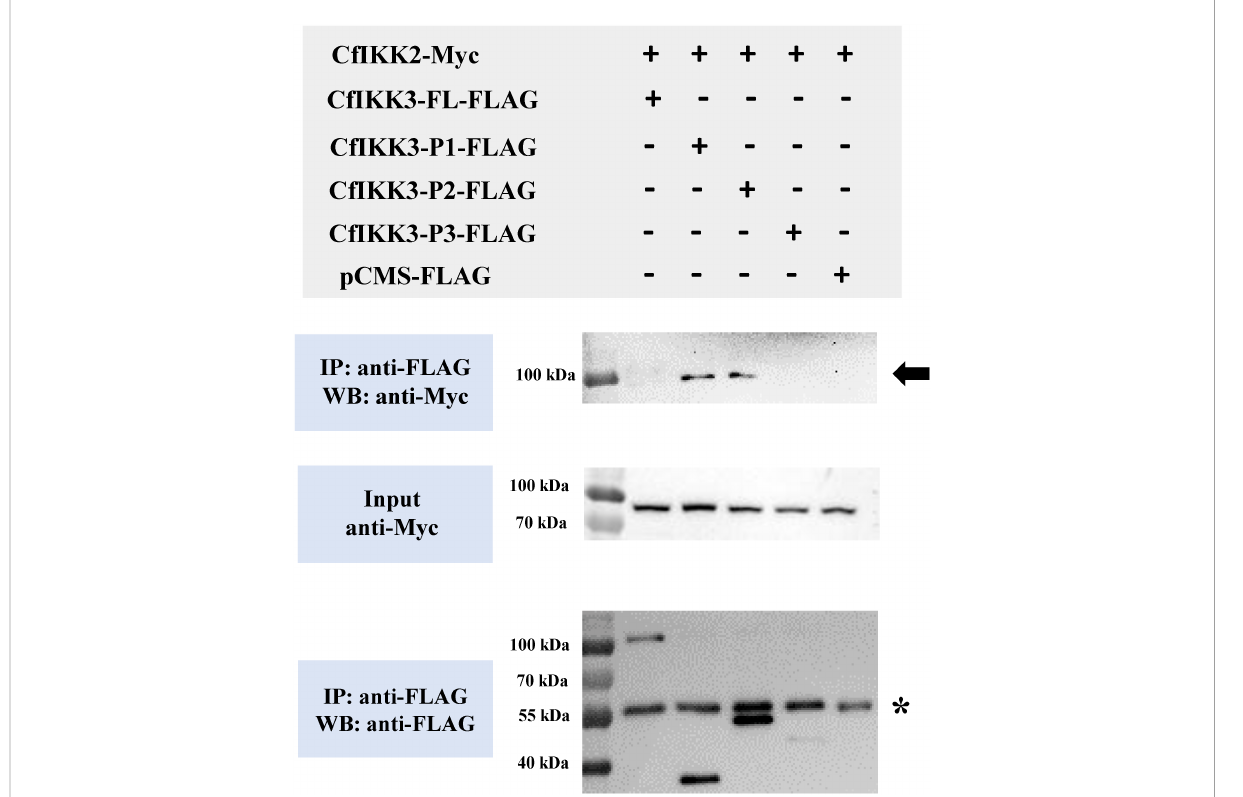
FIGURE 8 Co-immunoprecipitation (Co-IP) assays showed that TBK1/IKK ϵ family members of Zhikong scallop (CfIKK2 and CfIKK3) could bind each other. Co-IP results indicated the interaction of CfIKK2-Myc with CfIKK3-P1-FLAG and CfIKK3-P2-FLAG. Asterisk represents the heavy chain of mouse